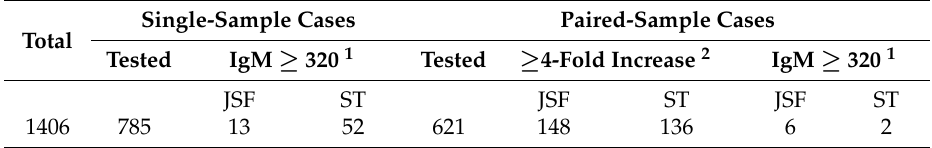
Table 1. Summary of the tested cases for Japanese spotted fever and scrub typhus.